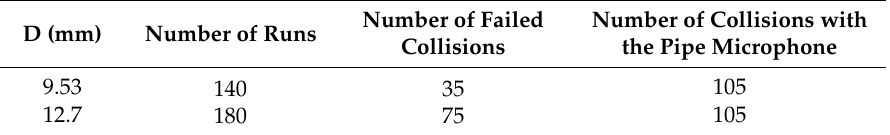
Table 4. Number of particles used in the